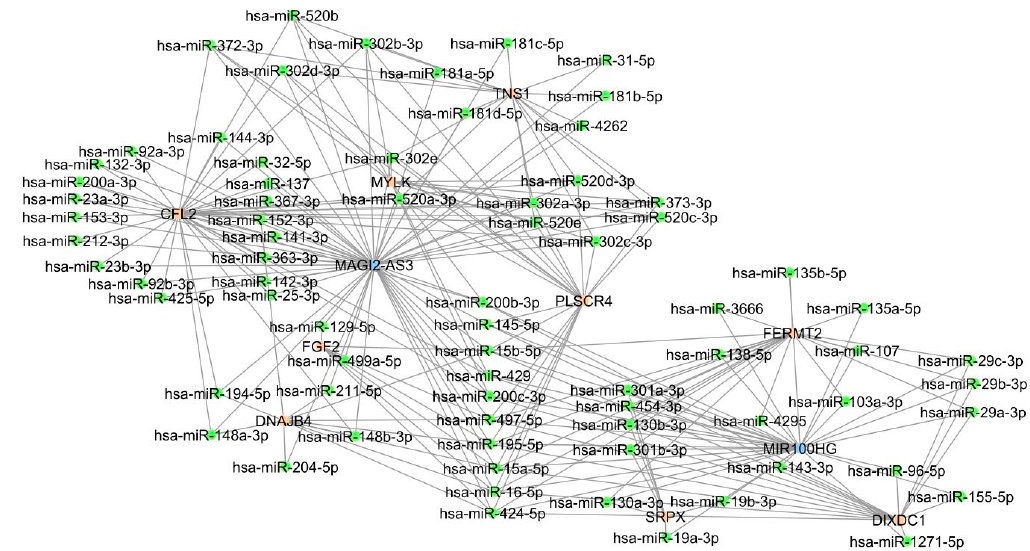
Figure 3. The shared competing endogenous RNA network across five hormone ‐ dependent (HD) cancers, breast, prostate, colon, rectal, and endometrial, was constructed by the Cytoscape tool [24]. The blue ‐ , orange ‐ , and green ‐ coloured circles represent long non ‐ coding RNAs, mRNAs, and microRNAs, respectively.